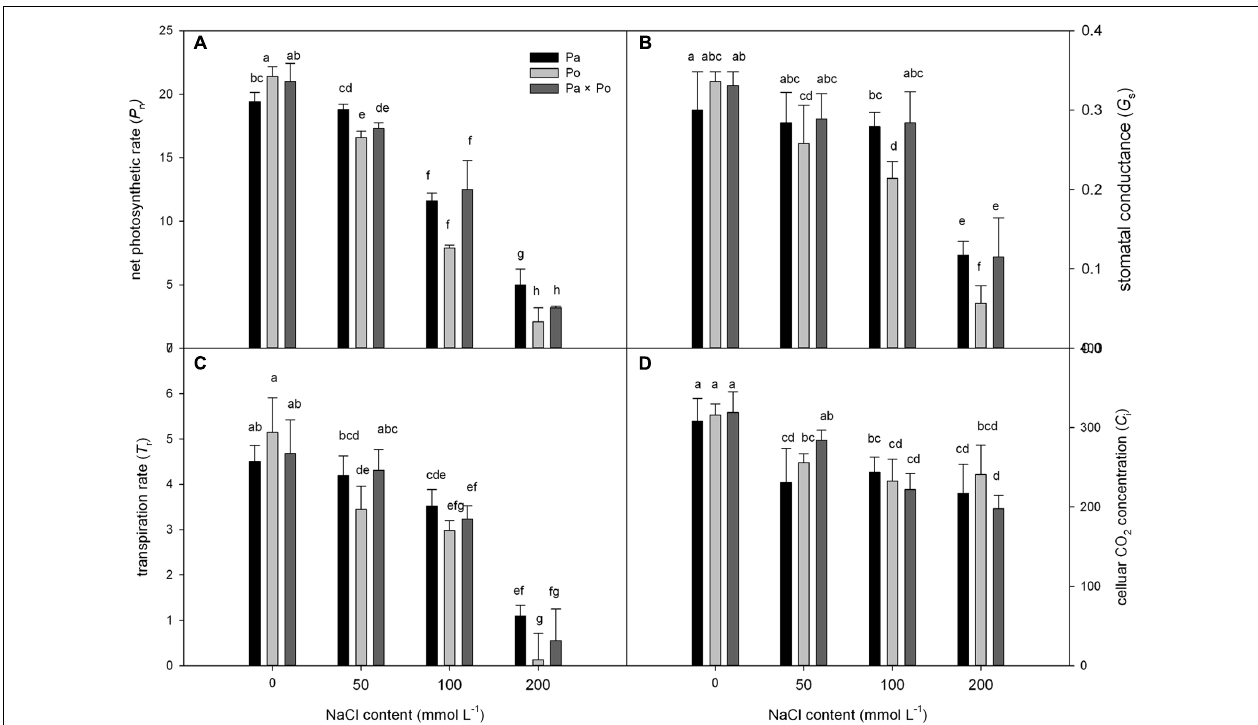
FIGURE 1 | The effect of salt stress on the photosynthetic gas exchange parameters of leaves of three Physocarpus amurensis . Net photosynthetic rate (A) , stomatal conductance (B) , transpiration rate (C) , and celluar CO 2 concentration (D) . Note: Pa, P. amurensis Maxim ( Maxim ( ) × P. opulifolius “Diabolo” ( ). Data in the figure are mean ± SE; values followed by different lowercase letters indicate a significant difference ( p < 0.05). ♀ ♂